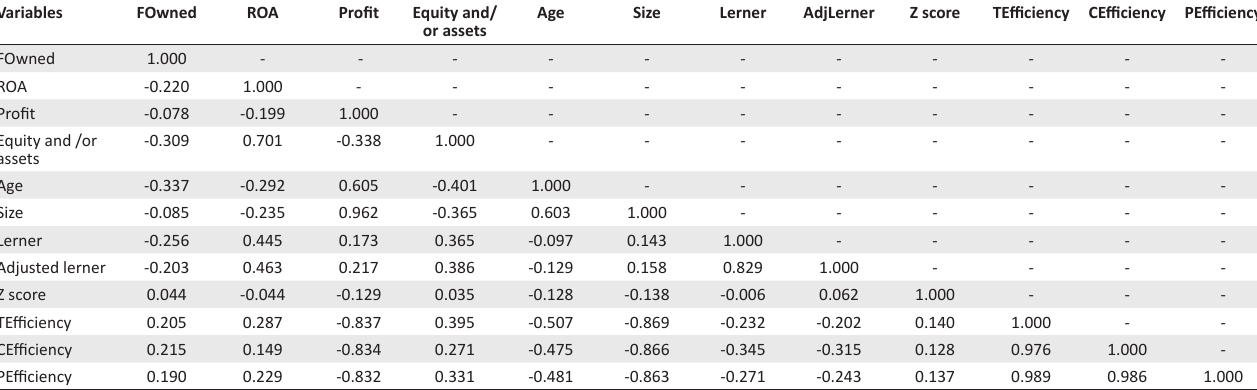
TABLE 2-A1: Correlation matrix.